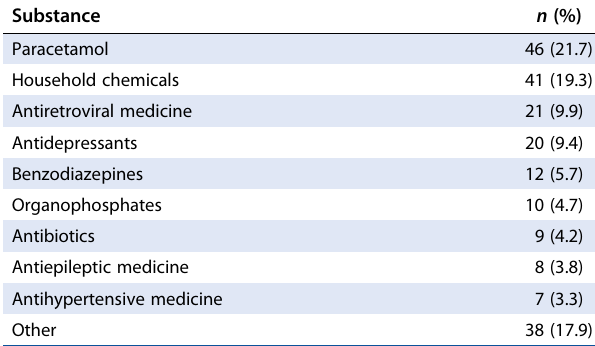
Table 2: Main type of drug or poison ingested during the deliberate self-poisoning